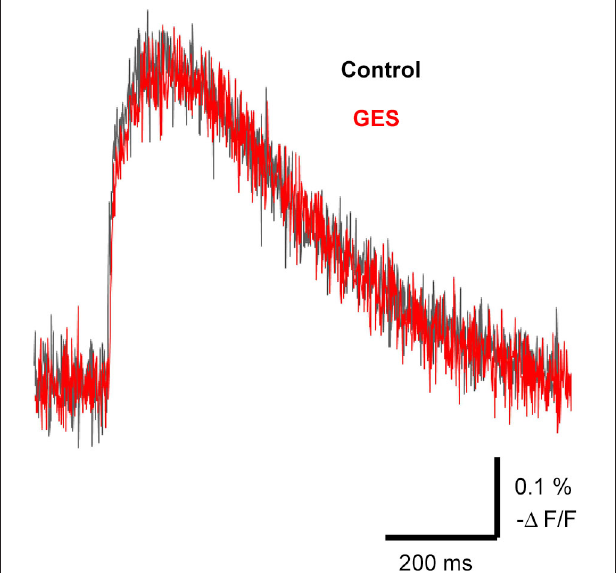
FIGURE 7 | Propagation of excitation was not affected by the taurine transporter inhibitor GES . Typical traces of evoked optical signals with or without GES. Note that application of GES (1 mM) did not affect the amplitude of the signals (red trace). GES was applied at least for 10 min before